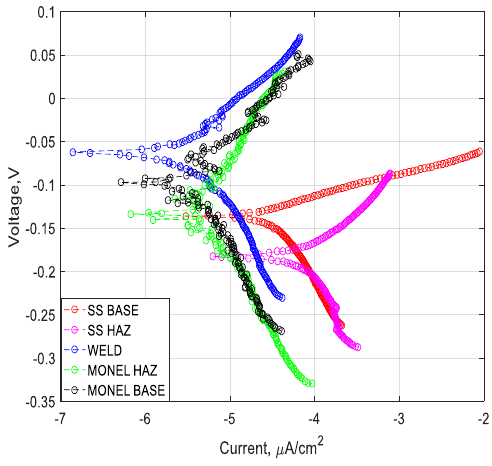
Figure 10. Polarization graphs—specimen CT.